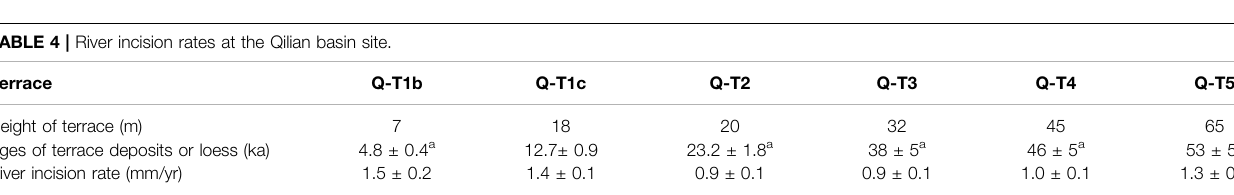
TABLE 4 | River incision rates at the Qilian basin